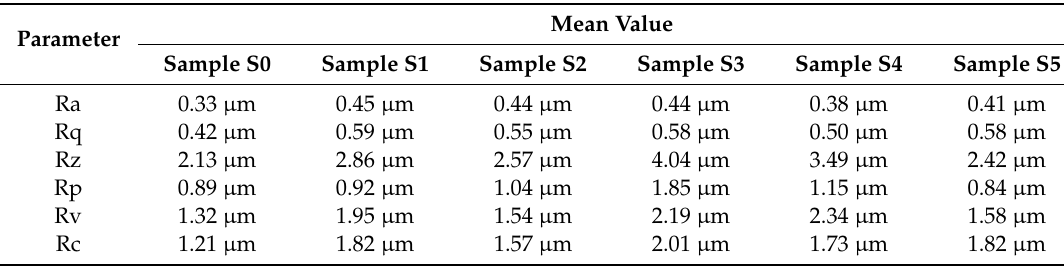
Table 6. Mean values of roughness.